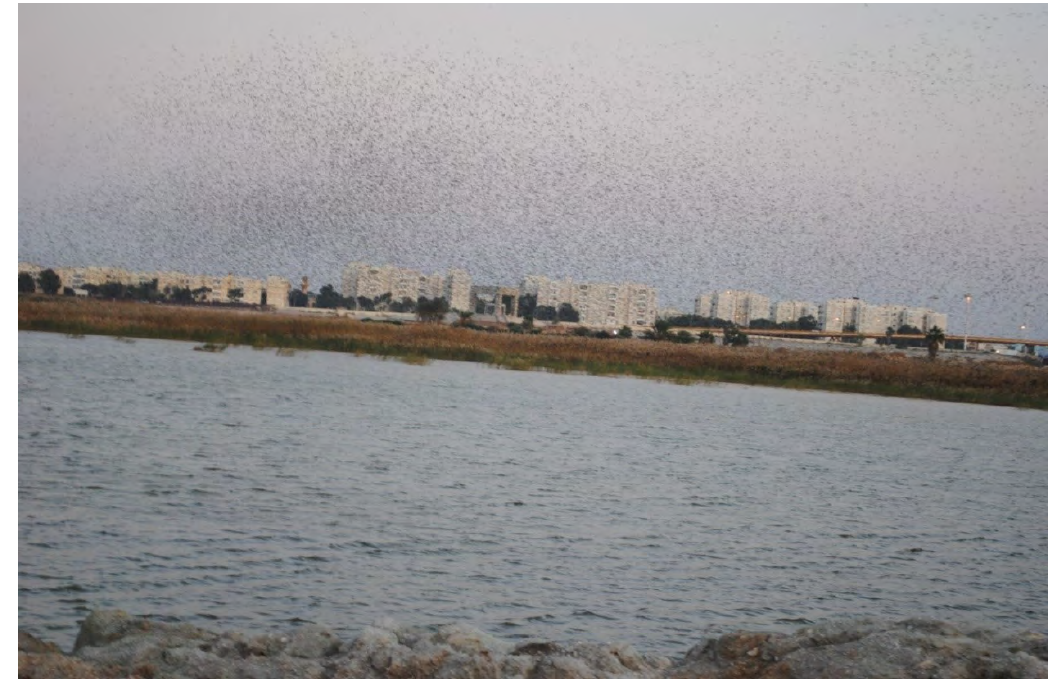
Figure 6. Juliana Lake: A Benghazi Wetland In Distress. 2013. [10].